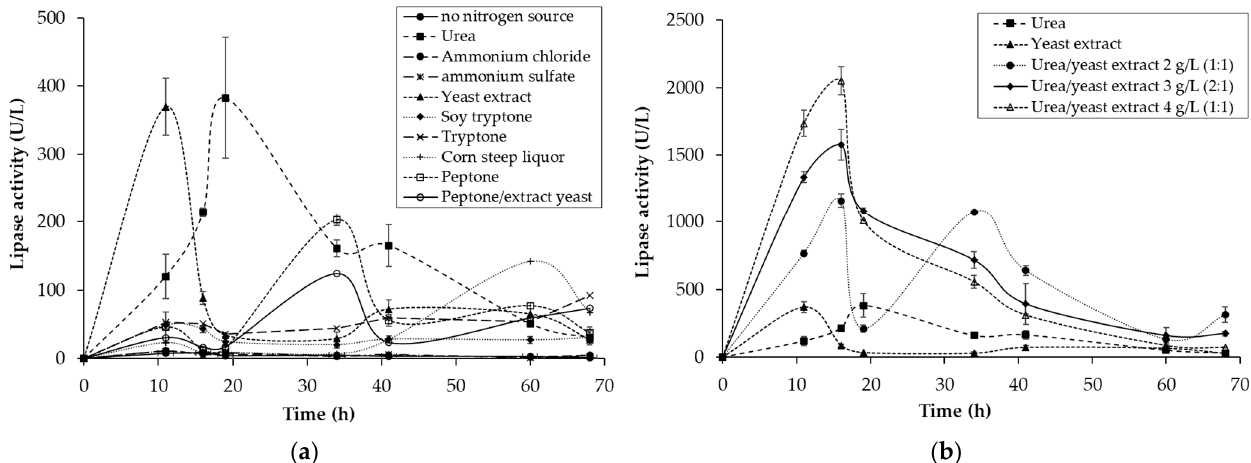
Figure 2. Kinetic profile of extracellular lipase activity during submerged cultivation of Yarrowia lipolytica in Erlenmeyer flasks with pomegranate-seed residue (PSR) with and without supplementation of nitrogen sources: ( a ) testing of several nitrogen sources with PSR; ( b ) the best nitrogen sources (urea and yeast extract) with PSR and their combination.